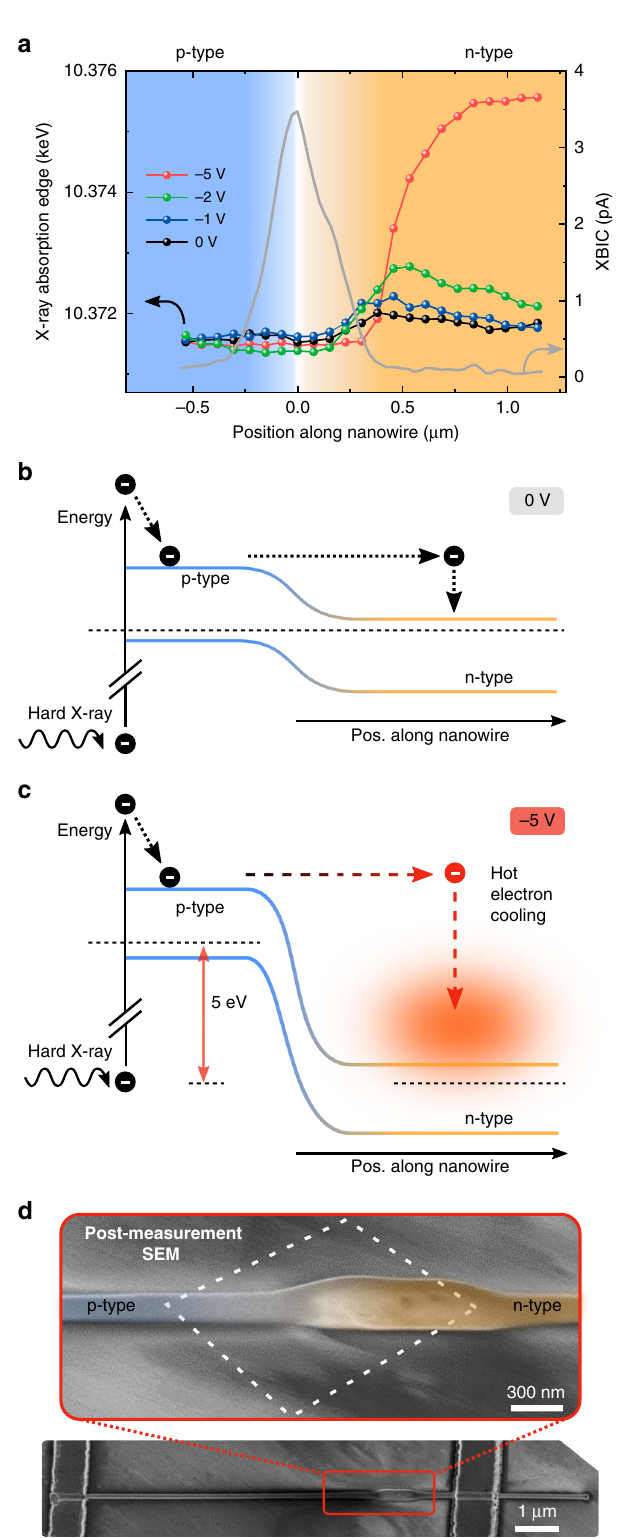
Fig. 5 Hot electron induced selective oxidization. a Line scan along the nanowire of Ga K-edge energies (colored dot symbol lines on the left y - axis) for the different applied bias voltages. The X-ray beam induced current (XBIC) signal (grey, solid line on the right y -axis) for 0 V is additionally displayed to precisely locate the position of the p – n junction. b , c Schematic band diagrams along the p – n junction explaining the observed oxidization in the n-doped part due to hot electrons accelerated by the built-in voltage at the p – n junction. d Colorized SEM image of the device after all measurements (tilted by 50° with respect to the sample surface). The dashed line indicates the measurement region for the